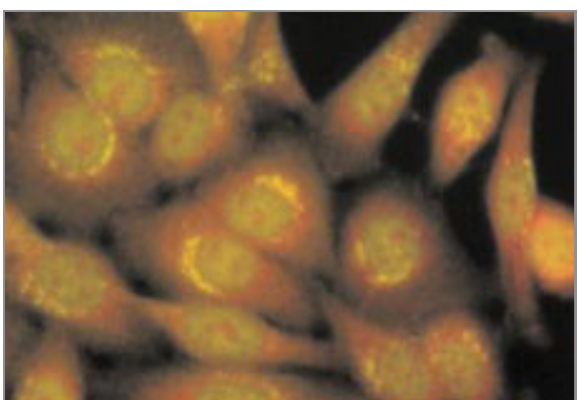
Figura 16 – Citoplasmático pontilhado polar